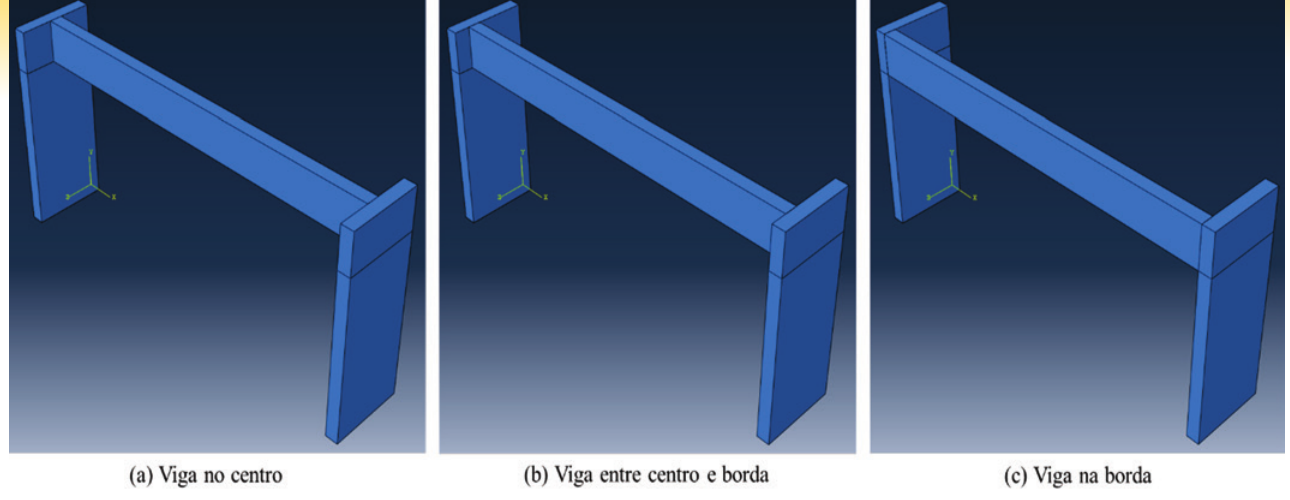
Ilustração da excentricidade das vigas em relação aos